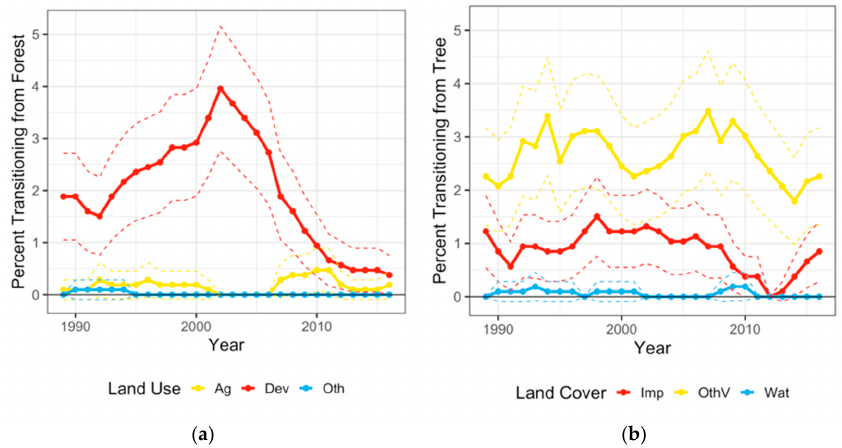
Figure 9. Transitional change from ( a ) forest land use and ( b ) tree land cover with 95% confidence intervals at five-year intervals from TimeSync observations.